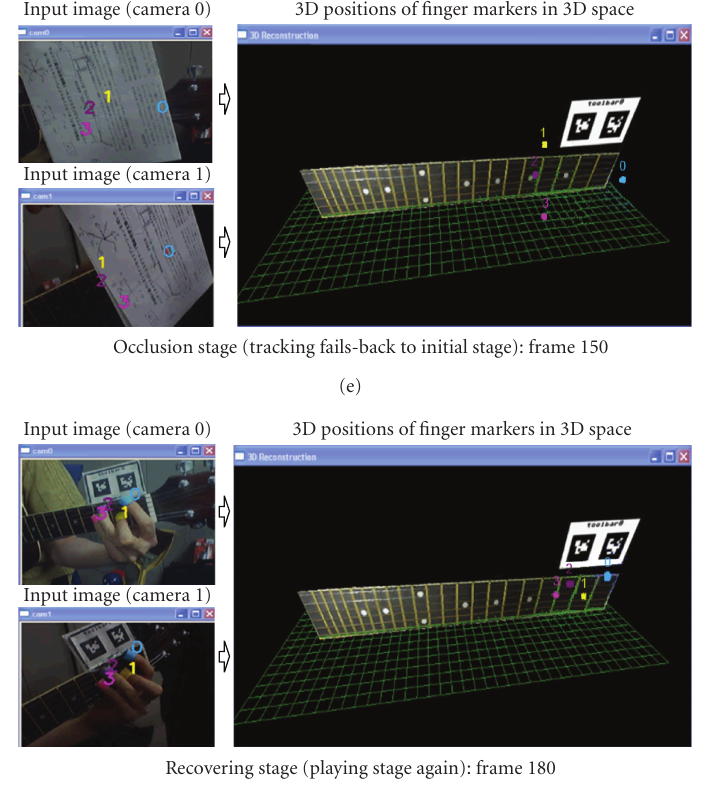
marker-colored areas to the number of marker- colored image points in the training